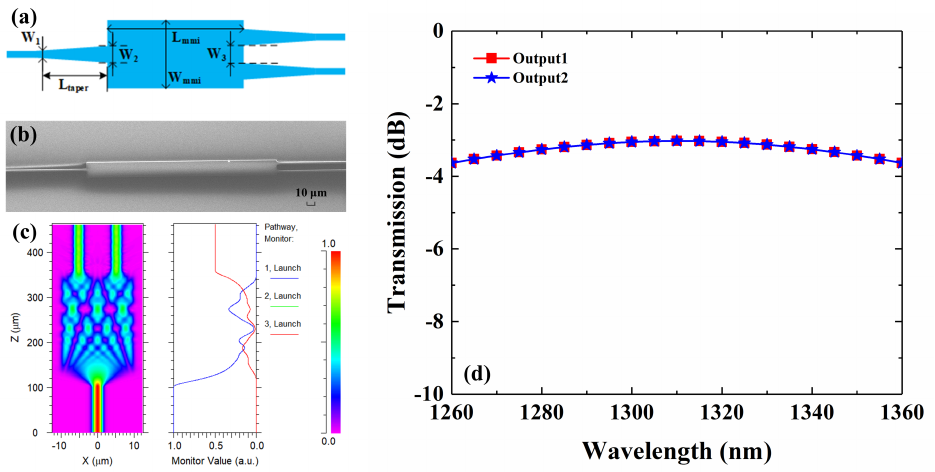
Figure 1. ( a ) The schematic of the optimized MMI; ( b ) SEM image of the fabricated MMI; ( c ) Calcu- lated field distribution along the MMI at 1310 nm; ( d ) Calculated spectra from the two output ports of the